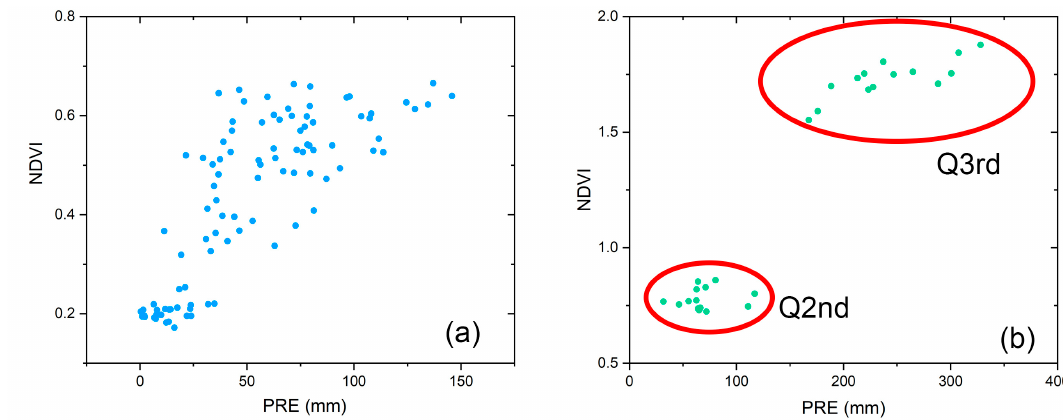
Figure 11. ( a ) Monthly correlation between NDVI and precipitation in vegetation growing season, ( b ) seasonal correlation between NDVI and precipitation in Q2nd and Q3rd.